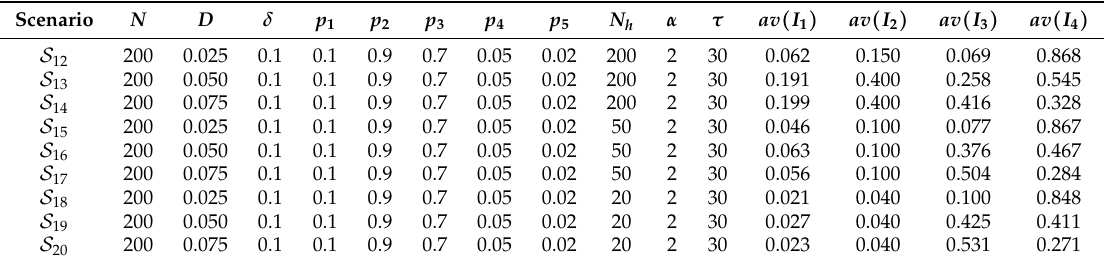
Table 3. Numerical values of the EED parameters for scenarios S i , i = 12, . . . ,20, and the average of the cost indices av ( I j ) , j = 1, . . . ,4, for 10 independent runs.